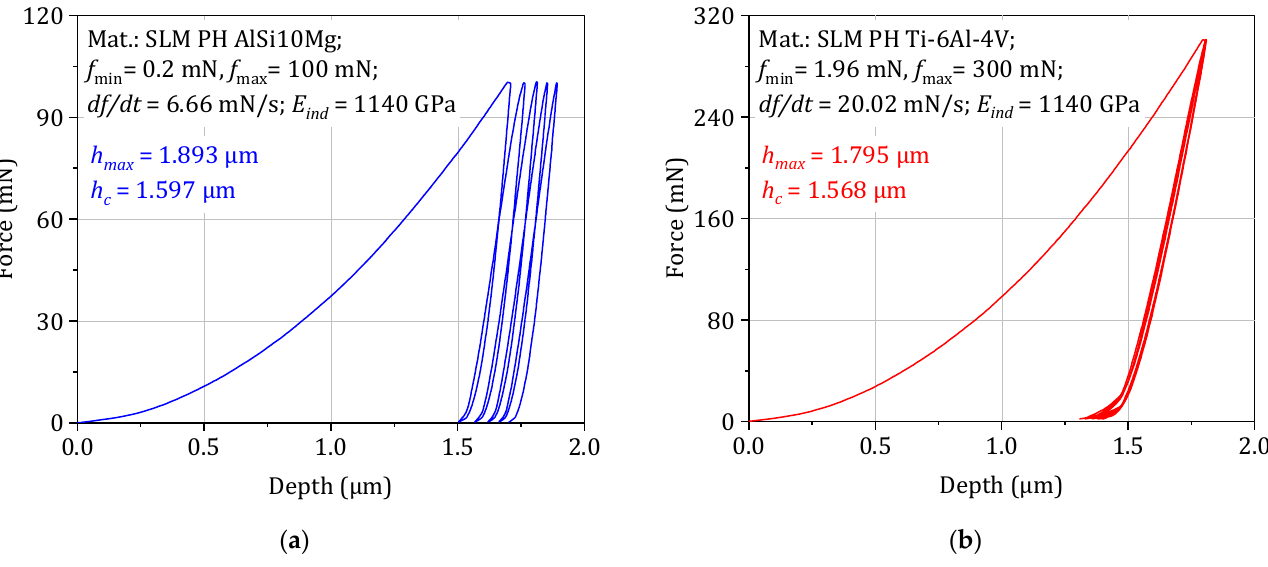
Figure 1. Comparison between ultra-micro indentation behavior in ( a ) AlSi10Mg and ( b ) Ti-6Al-4V.